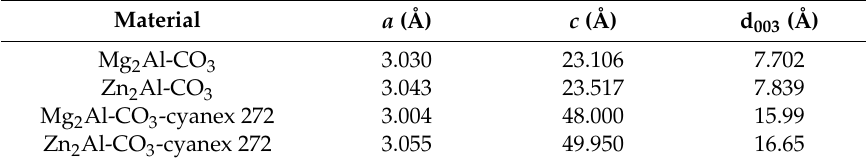
Table 1. Unit cell parameters of Mg 2- Al-CO 3 , Zn 2 Al-CO 3 , Zn 2- Al-CO 3 -cyanex 272, and Mg 2 -Al-cyanex272 materials.